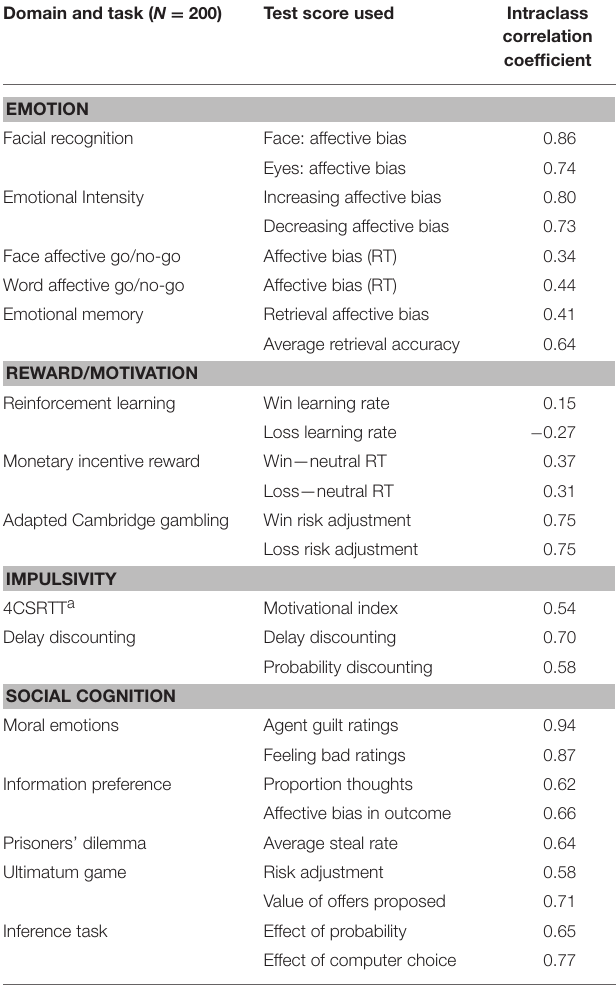
TABLE 5 | Test re-test reliability. Domain and task ( N = 200